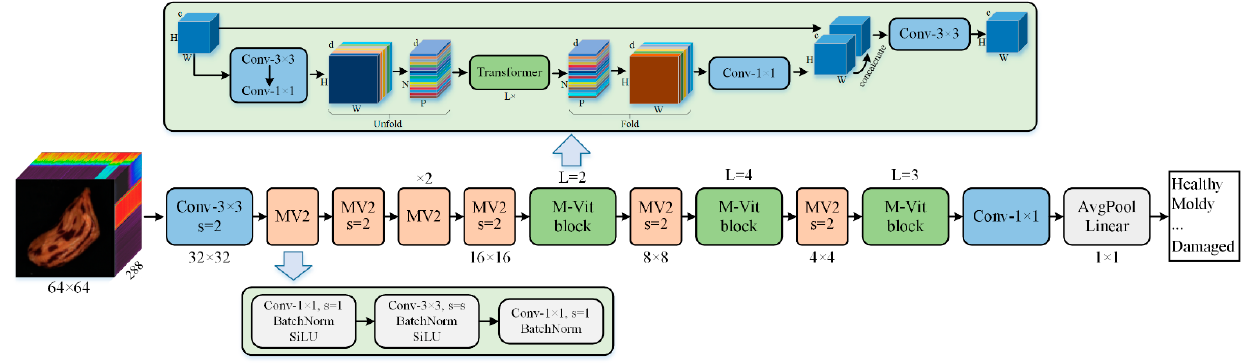
Figure 2. Model structure of MobileViT-xs. MV2: MobileNetv2 block, s: stride, M-Vit block: MobileViT block, H: height; W: width; c: channels; P: the number of pixels in the patch; N: the number of patches; L: the number of transformer blocks.